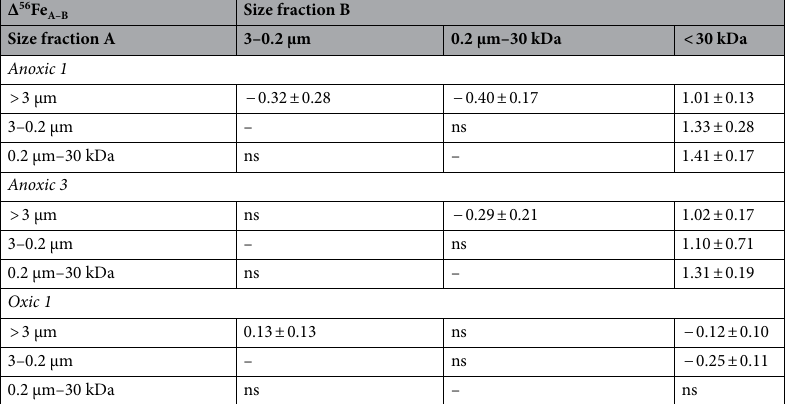
Table 2. Iron isotopic fractionation (Δ 56 Fe A–B ) between the size fraction A (on the left, yellow column) and the size fraction B (on the top, blue row). The values were calculated by subtracting the δ 56 Fe of the fraction from the δ 56 Fe of the fraction A. The Δ 56 Fe A–B errors were calculated using Eq. (7). For the oxic period 3, after vent removing, no significant Fe isotopic fractionation was observed, because the high uncertainty obtained from error propagation calculation (Supplementary Table S3). – Not defined isotopic fractionation, ns no significant error